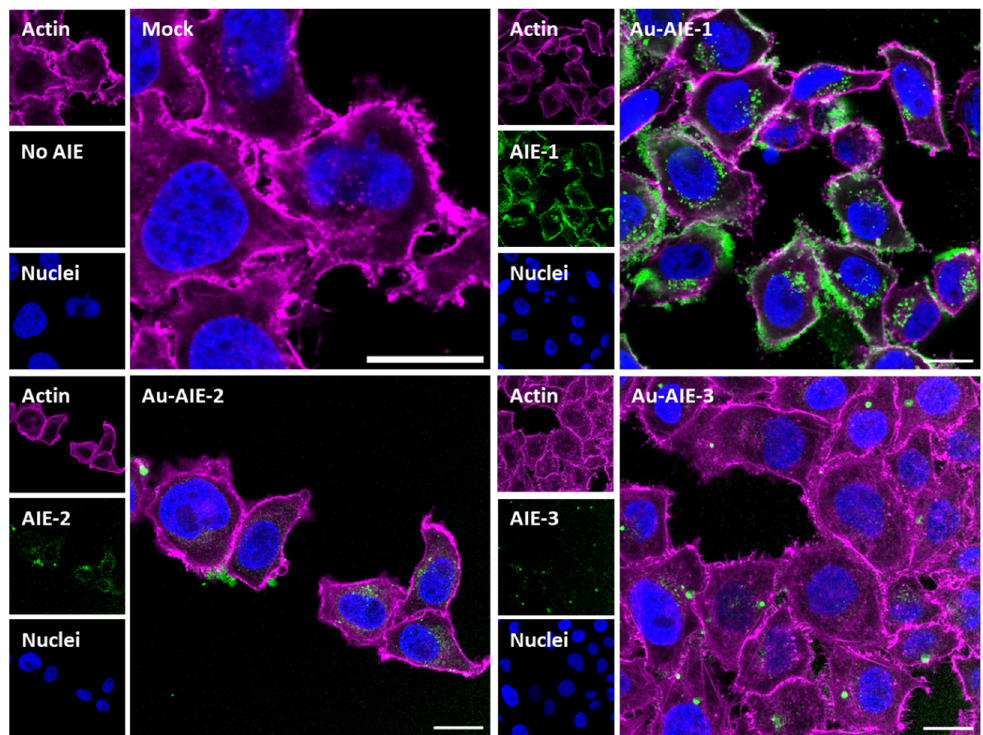
Figure 4. Confocal laser scanning images of HeLa Kyoto cells after incubation with Au ‐ AIE nanoparticles, dispersed in DMEM. The cells were incubated with nanoparticles for 24 h, then washed, fixed, and stained. All scale bars are 20 μ m.